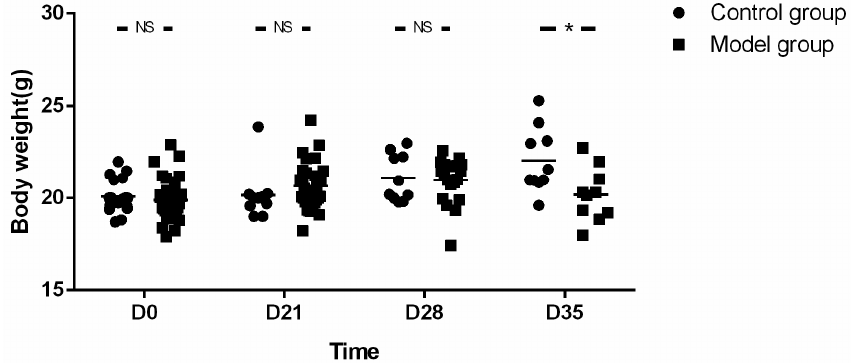
Figure 4. Body weight of mice. With the prolongation of OVA exposure time, body weight of mice in the model group was lower than in control group at the end of the experiment. Unpaired t -tests was used in comparison between groups and among different viewpoints in the model group. LESP: lower esophageal sphincter pressure. * p < 0.05, NS—not significant.